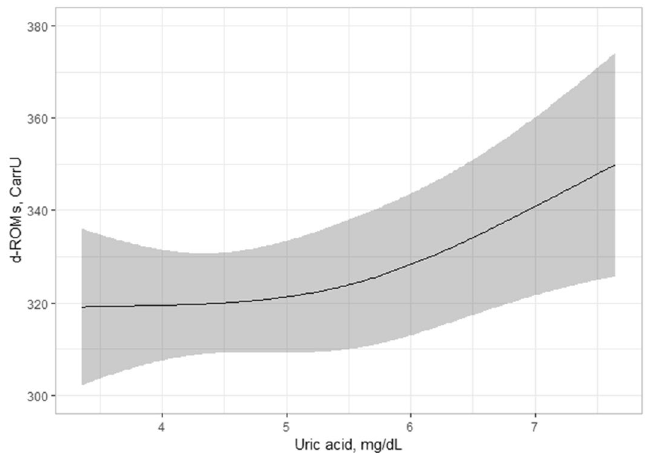
Figure 1. Serum uric acid and d-ROMs levels. The serum level of uric acid was significantly associated with d-ROMs level ( p = 0.045) and the nonlinear effect of that on d-ROMs level was also significant ( p = 0.171). Best fitted line and 95% CI results are shown by a solid line and gray band, respectively. Values for d-ROMs were adjusted according to the median values for age, gender, smoking habit, alcohol drinking habit, VFA, SBP, total cholesterol, HbA1c, eGFR, log HOMA-IR, log hs-CRP, and log plasma XOR activity. d-ROMs derivative of reactive oxygen metabolites, CI confidence interval, VFA visceral fat area, SBP systolic blood pressure, HbA1c glycated hemoglobin, eGFR estimated glomerular filtration rate, HOMA-IR homeostatic model assessment of insulin resistance, hs-CRP high-sensitivity C-reactive protein, XOR xanthine oxidoreductase.